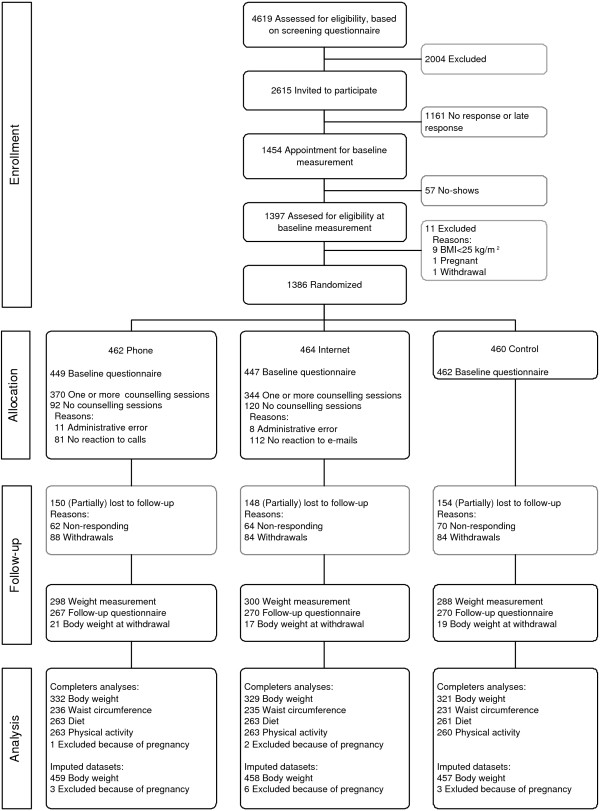
Participant flowchart. This chart illustrates the flow of participants through the trial and the response to the measurements. Analyses were performed for participants with either complete objective or complete subjective baseline- and follow-up data. Therefore the number of participants that was analysed in the completers-analyses is smaller than the number that responded to the follow-up measurements.